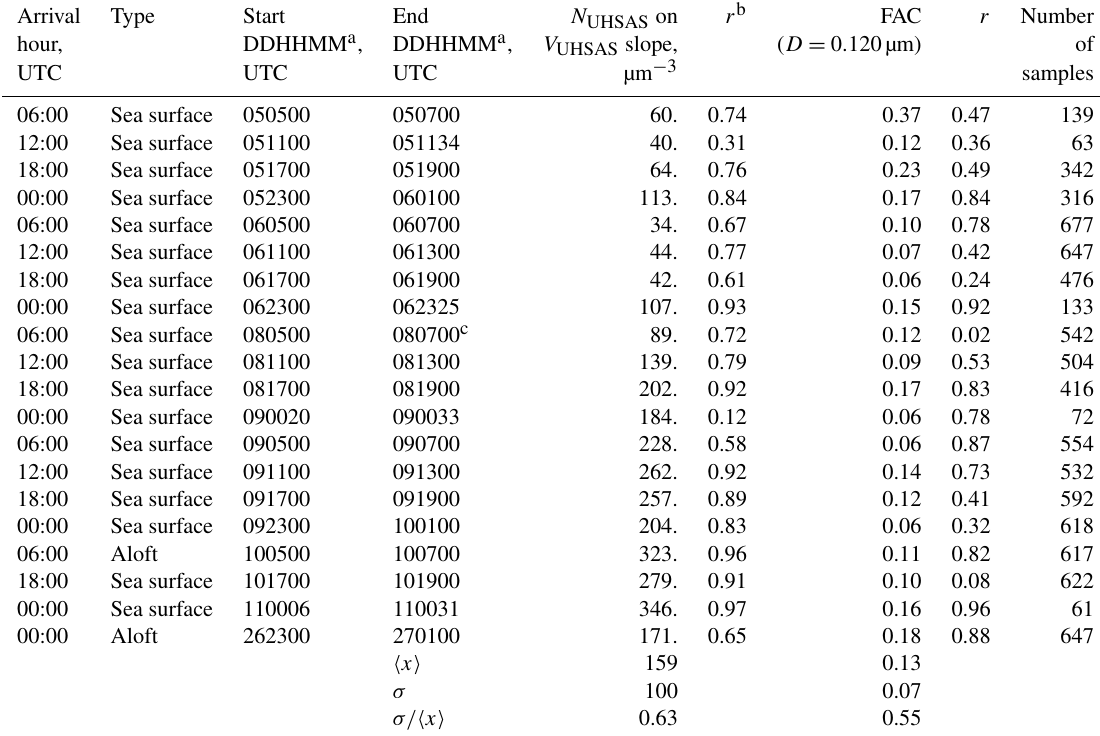
Table 4. Statistics for onshore trajectories ( D integration in Eqs. 2, 4, and 5 is from 0.120 to